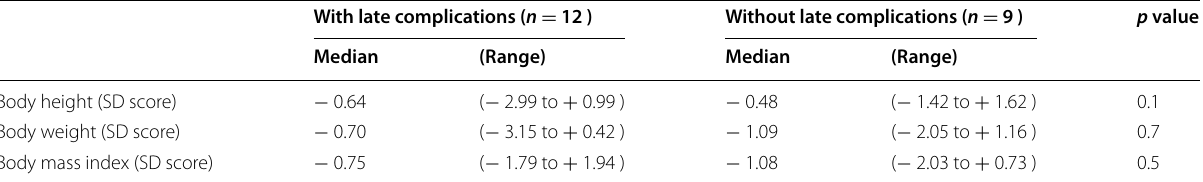
Table 3 Late complications and anthropometrics. Statistical analyses were performed by the Mann-Whitney U